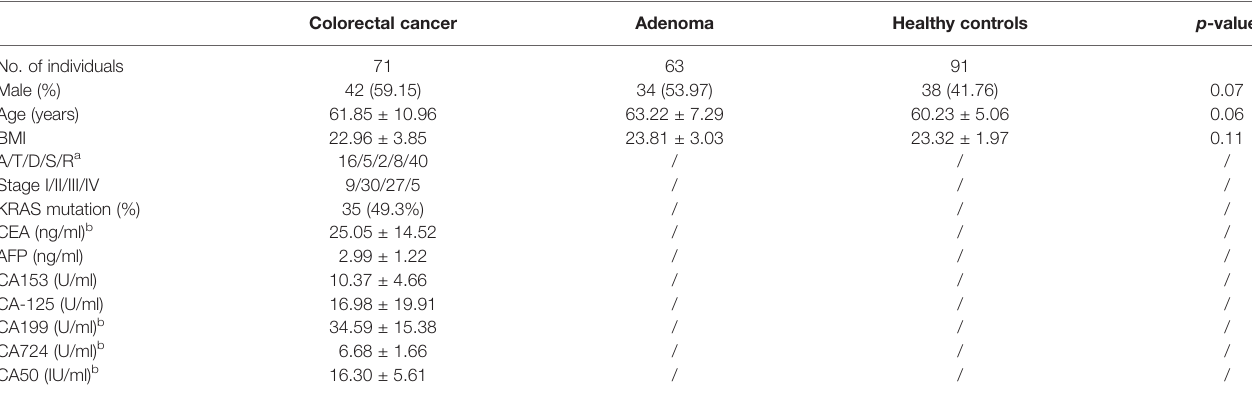
TABLE 1 | The characteristics of the studied subjects in the present study (mean ± standard deviation). Colorectal cancer Adenoma Healthy controls p